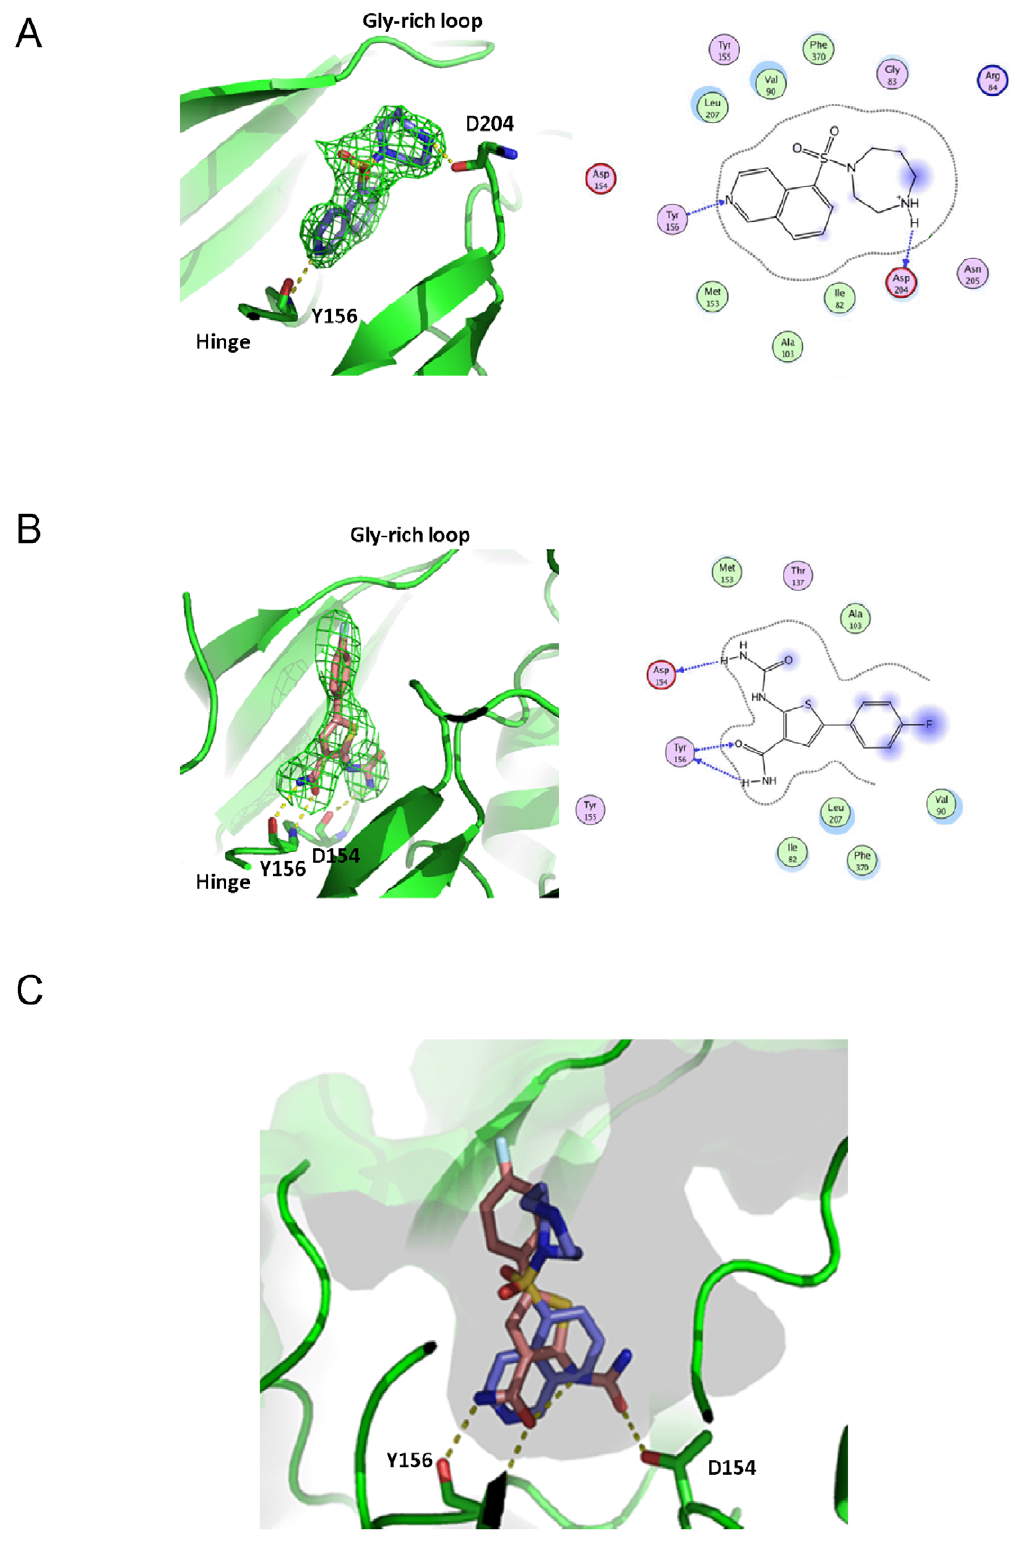
Figure 5. Positions of Fasudil and TPCA-1 in MRCK b active site. ( A ) Structure of Fasudil bound to the active site of MRCK b . Hydrogen bonds are marked with yellow dashed lines. The Fo–Fc omit map is shown contoured at 2 s , with the inhibitor modeled in the density. In the topology diagram, surface contour is shown with a gray dashed line and hydrogen bonds with blue dashed lines. Hydrophobic residues lining the cavity are shown in light green circles, and polar residues with light magenta. Blue shading indicates solvent exposed ligand groups. ( B ) Structure of TPCA-1 bound to the active site of MRCK b . ( C ) Overlay of the structures of Fasudil and TPCA-1 bound to the active site of MRCK b . doi:10.1371/journal.pone.0024825.g005 PLoS ONE |